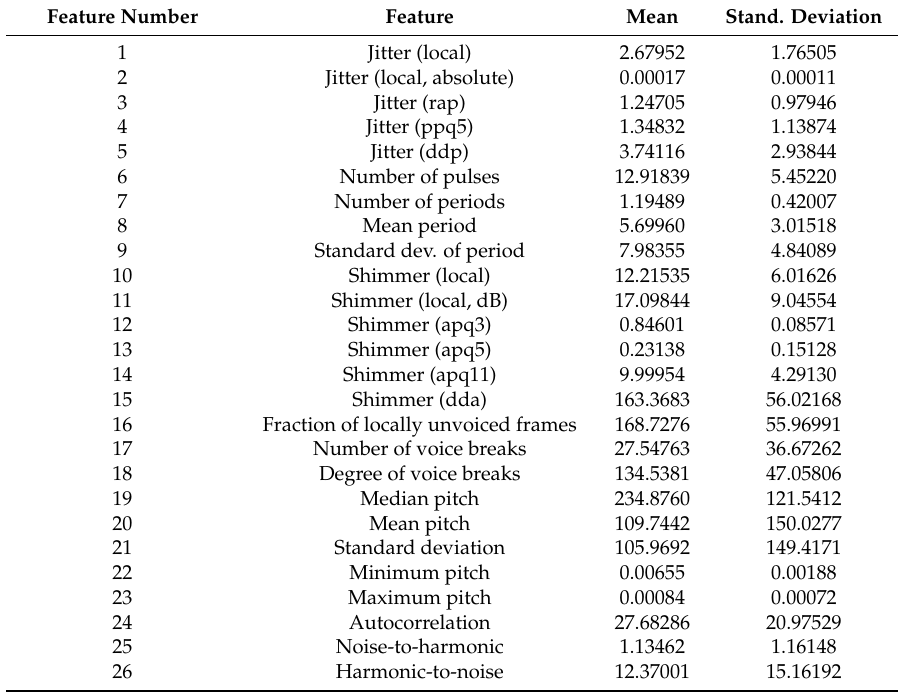
Table 1. Extracted time frequency-based features from individual voice samples [37].